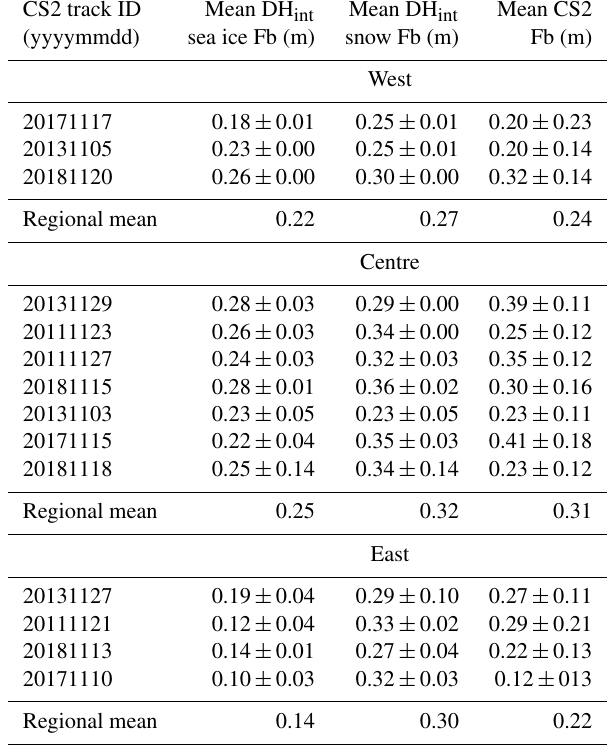
Table 1. Mean interpolated drill hole (DH int ) measured sea ice and snow freeboards (Fb) and CS2 freeboards for first-year fast ice only (over equivalent distances) for individual CS2 tracks in the west, centre and east. Regional mean values for tracks in the west, centre and east are given, and these statistics are used in Figs. 3 and 4. If sea ice freeboard or a penetration depth was determined for a CS2 track, a correction for the propagation of the radar wave through the snow was applied according to Kurtz et al.